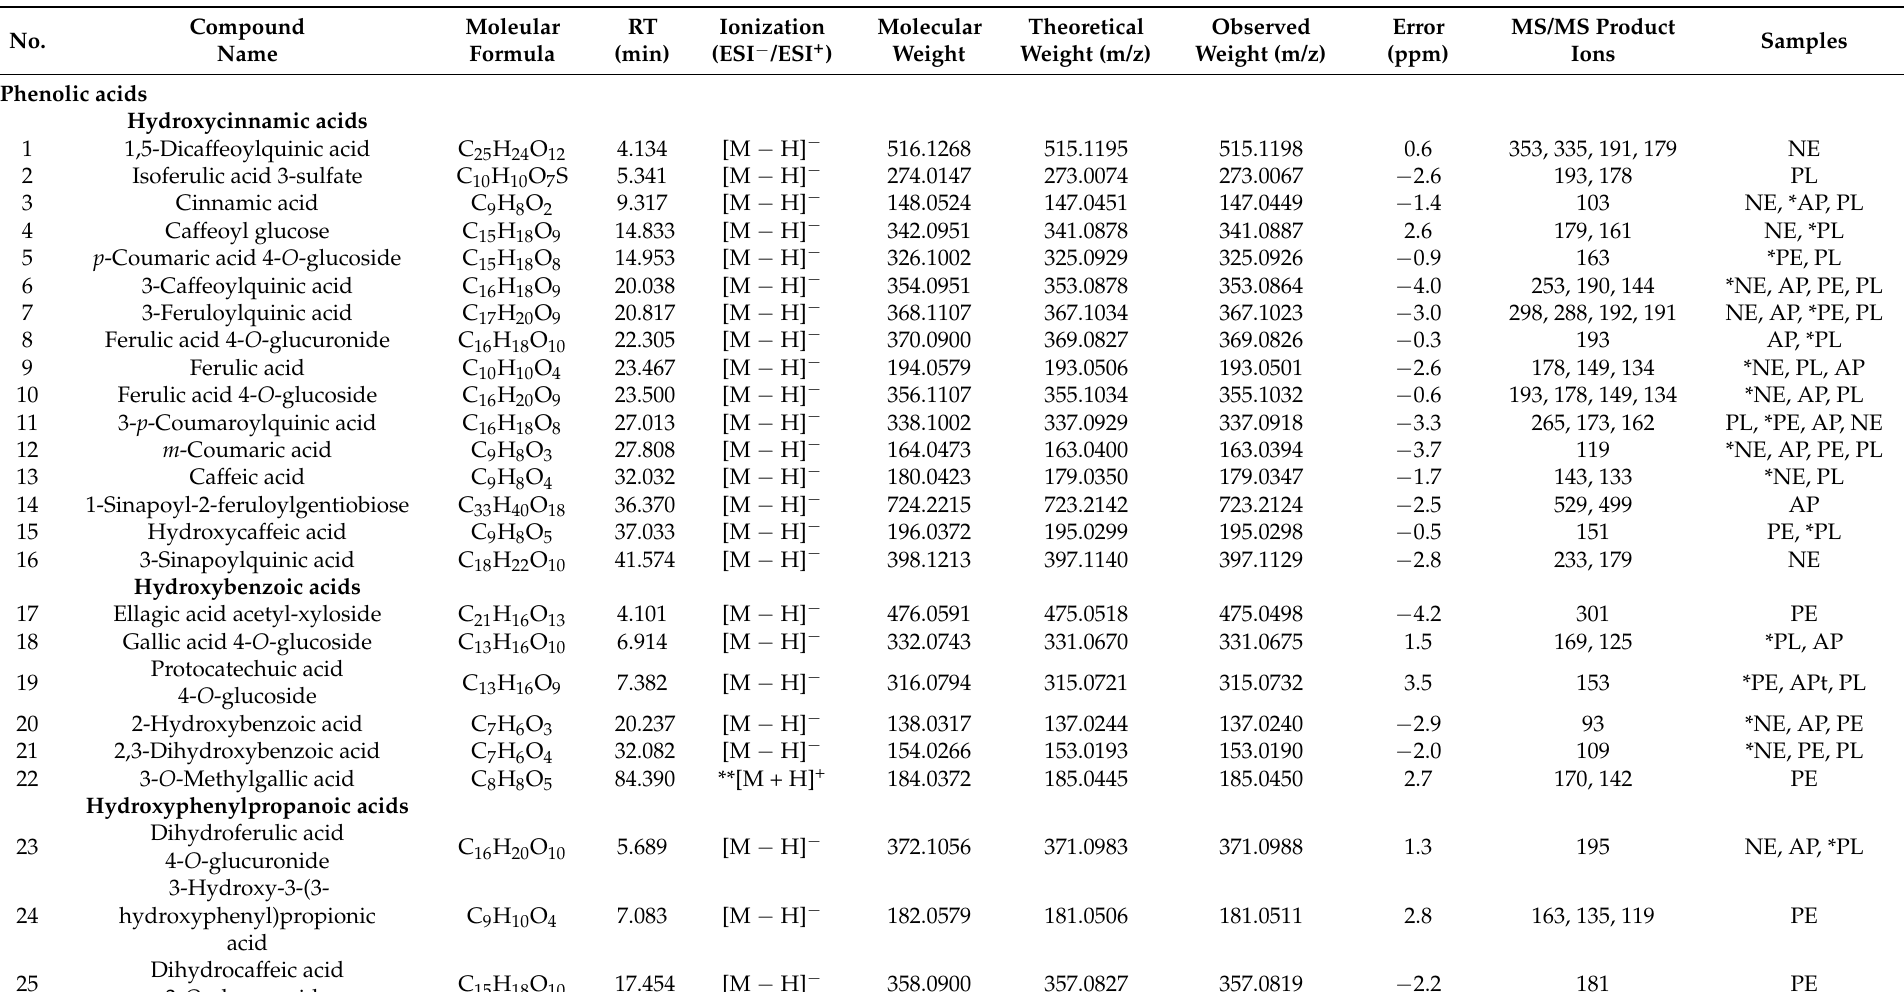
Table 3. Qualitative characterization of phenolic compounds in stone fruits waste by Liquid chromatography coupled with electrospray-ionization quadrupole time-of-flight mass spectrometry